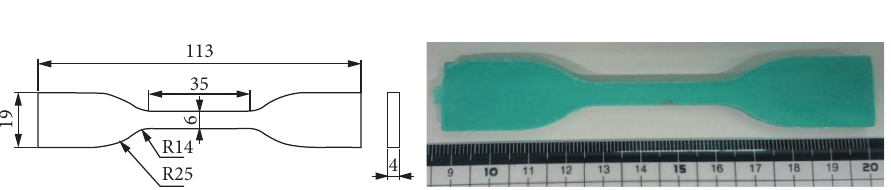
Figure 1: Sample size of the tensile test.